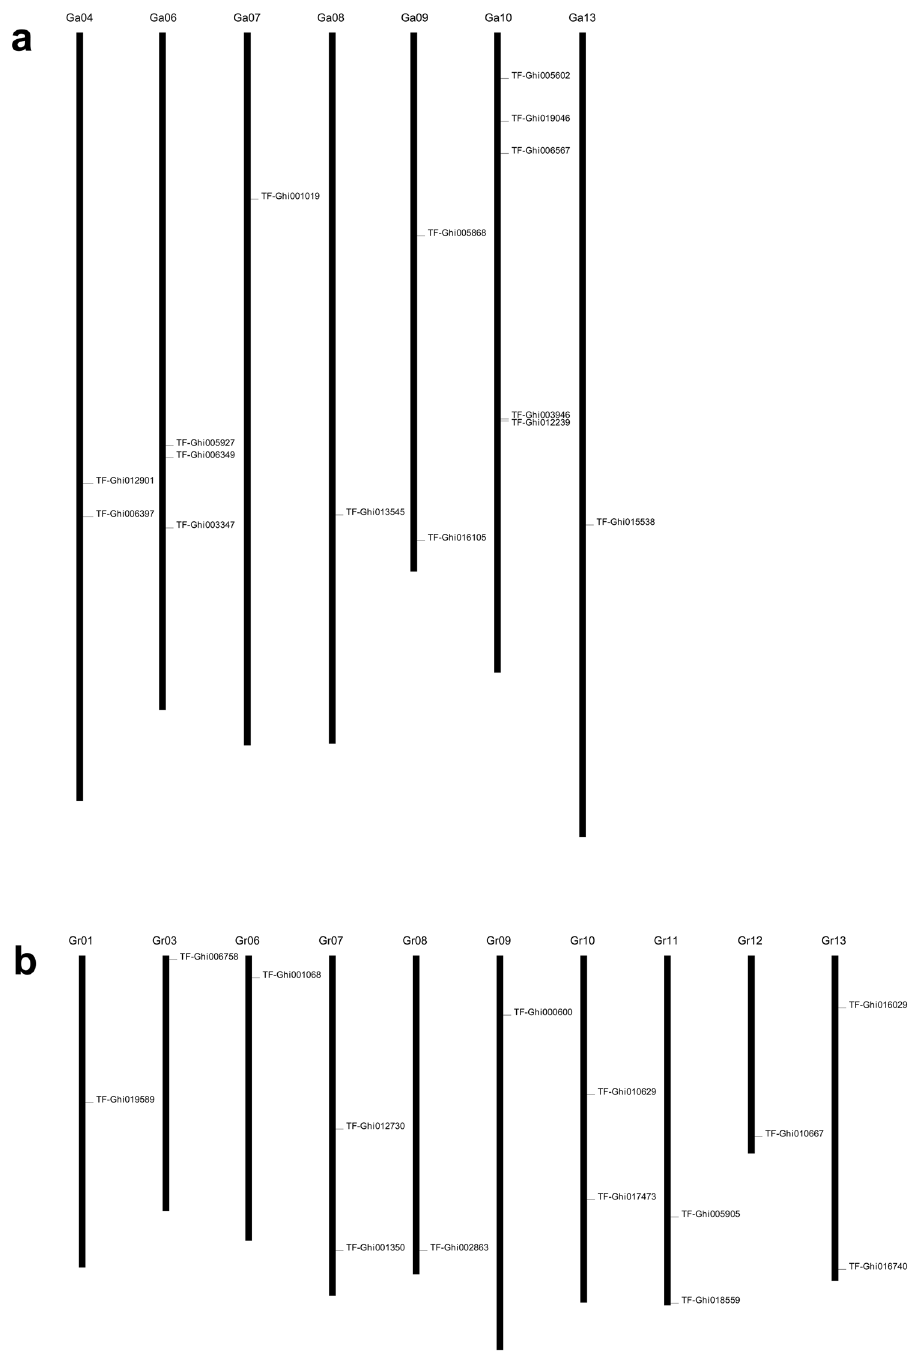
Fig 3. Chromosomal location of TFs in the A 2 genome of G . arboretum (a) and D 5 genome of G . raimondii (b).